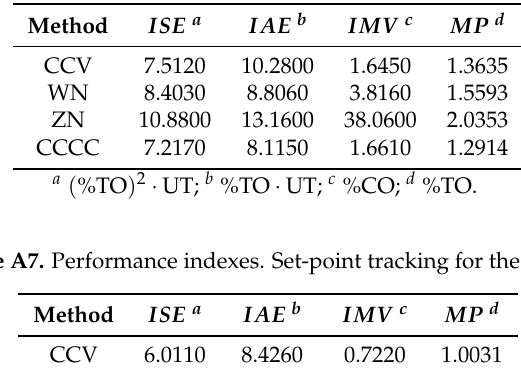
Table A6. Performance indexes. Disturbance rejection for the set P 3 .